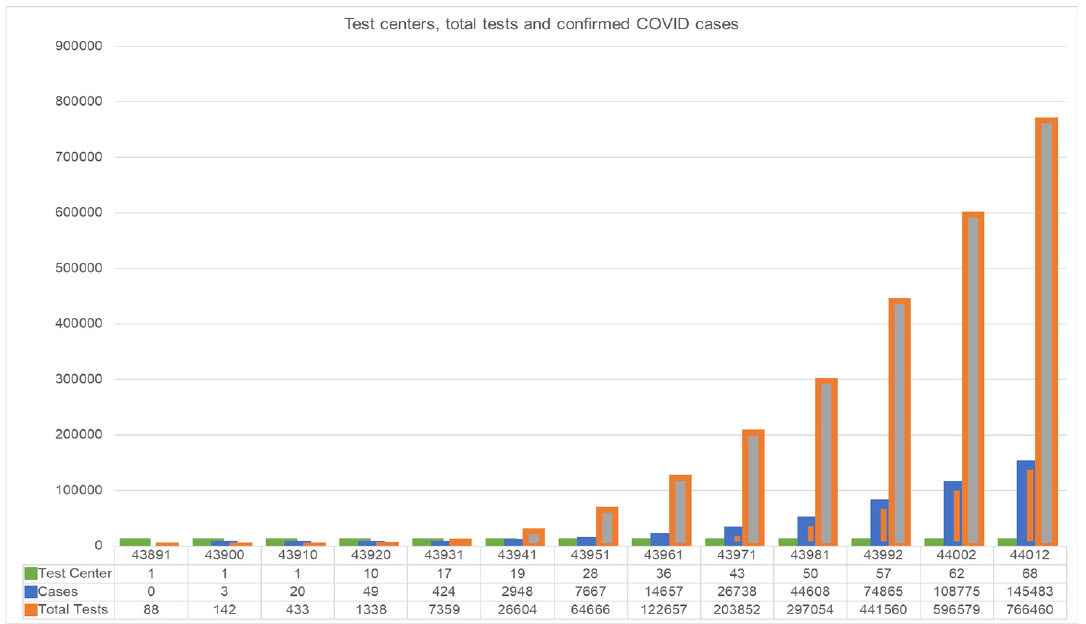
Figure 7. Temporal variation of testing centers, test cases and confirmed COVID-19 cases.